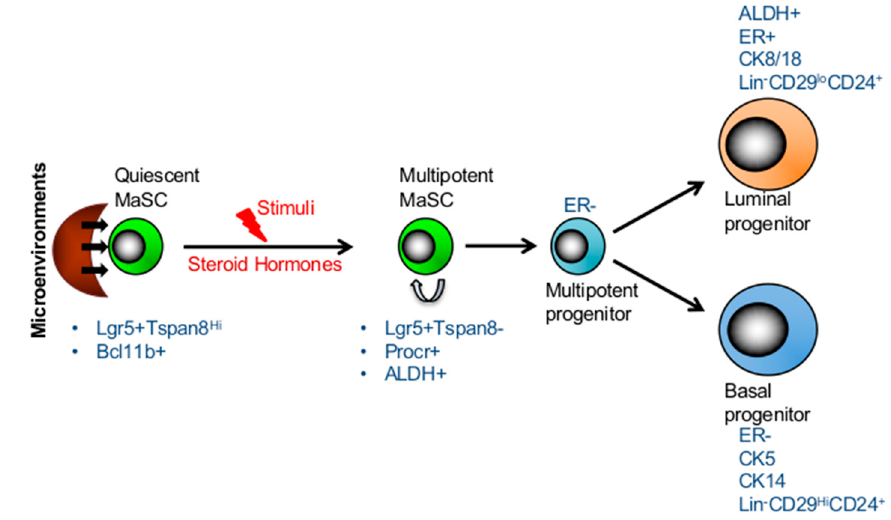
Figure 1. Hierarchical structure and plasticity of mammary stem cells. The transition between long-lived, quiescent, and proliferating MaSCs is regulated by its microenvironment. Quiescent MaSCs can re-ender the cell cycle and give rise to both lineages in response to stimuli, such as steroid hormones in the adult mammary gland. The markers of two subsets of stem cells and progenitors are presented in the figure.